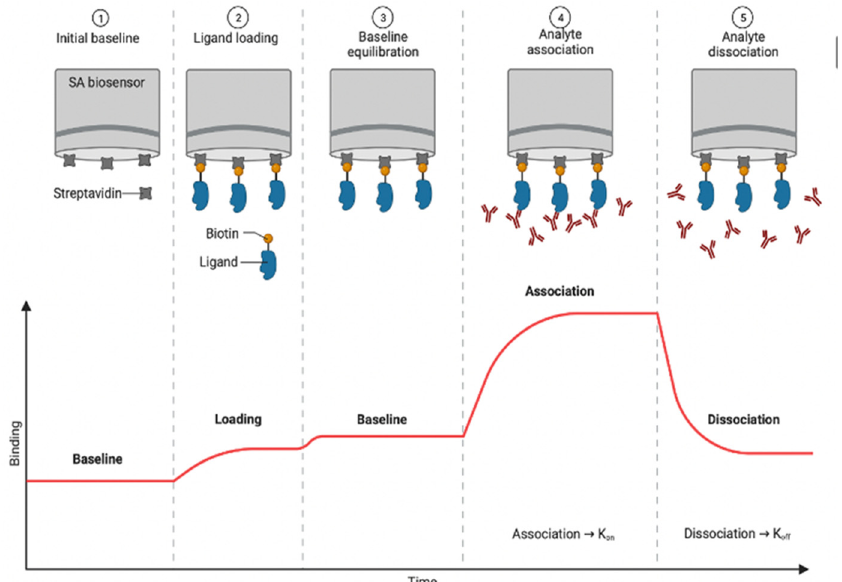
Figure 4. Experimental steps and representative (ideal) sensorgrams in a BLI assay based on Streptavidin fibers (SA biosensors) biosensors. Experimental steps showing the initial baseline in buffer (1), ligand loading using the streptavidin-biotin coupling method (2), baseline equilibration for drift correction in buffer (3), association with target analyte (4), and dissociation of ligand-analyte complex (5) (Figure created in BioRender (accessed on May 5, 2022)). Note that the loading plot shown here is for 100% surface coverage, which is not ideal for kinetic studies due to steric hindrance.